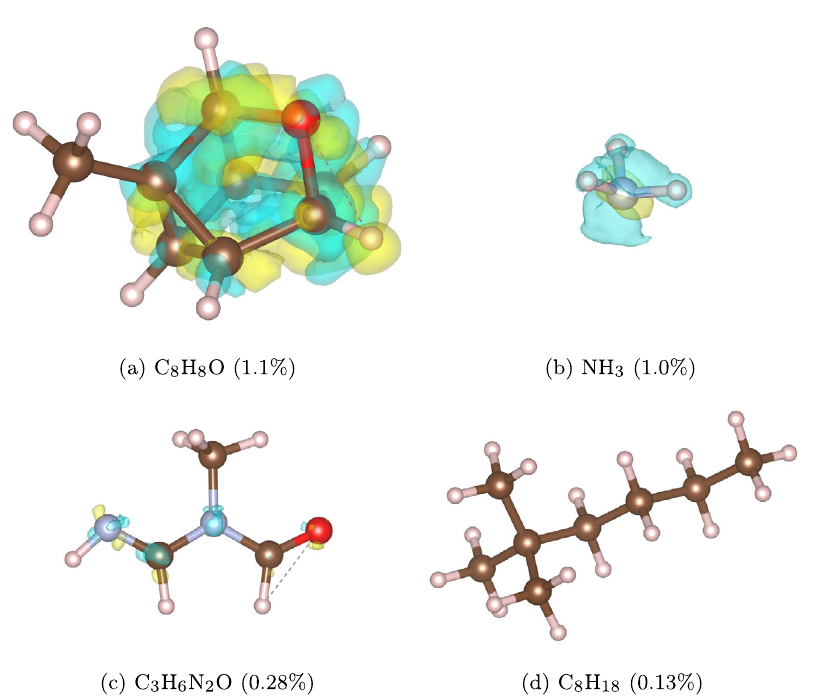
Fig. 3 Prediction error isosurfaces ± 0.001 e Bohr − 3 for four example QM9 molecules from the test set with hydrogen (white), carbon (brown), oxygen (red) and nitrogen (blue). The error percentages in parenthesis denote the normalized mean absolute error ε mae for each molecule. The chosen examples are two very high error molecules ( a ) and ( b ), an example with average error ( c ) and the molecule with the lowest error of all in the test set ( d